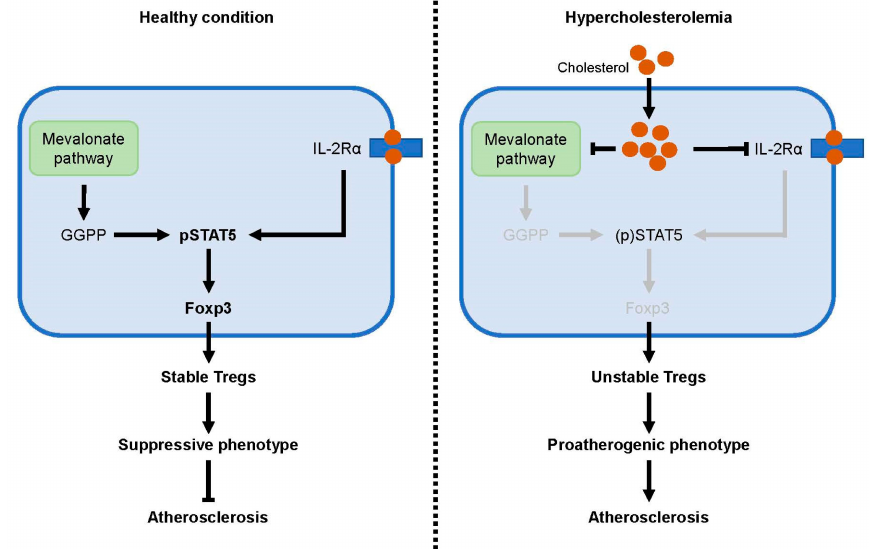
Figure 3. Hypercholesterolemia disrupts intracellular cholesterol homeostasis and Treg stability. IL-2 signaling induces phosphorylation of STAT5, known to induce and sustain Foxp3 expression. GGPP, a product of the mevalonate pathway, is indispensable for Treg stability and enhances STAT5 phosphorylation. Accumulation of intracellular cholesterol during hypercholesterolemia may inhibit the mevalonate pathway or reduce expression of IL-2R α , leading to diminished Treg stability. Unstable Tregs can lose their suppressive phenotype and adapt proatherogenic features, thereby promoting atherosclerotic disease